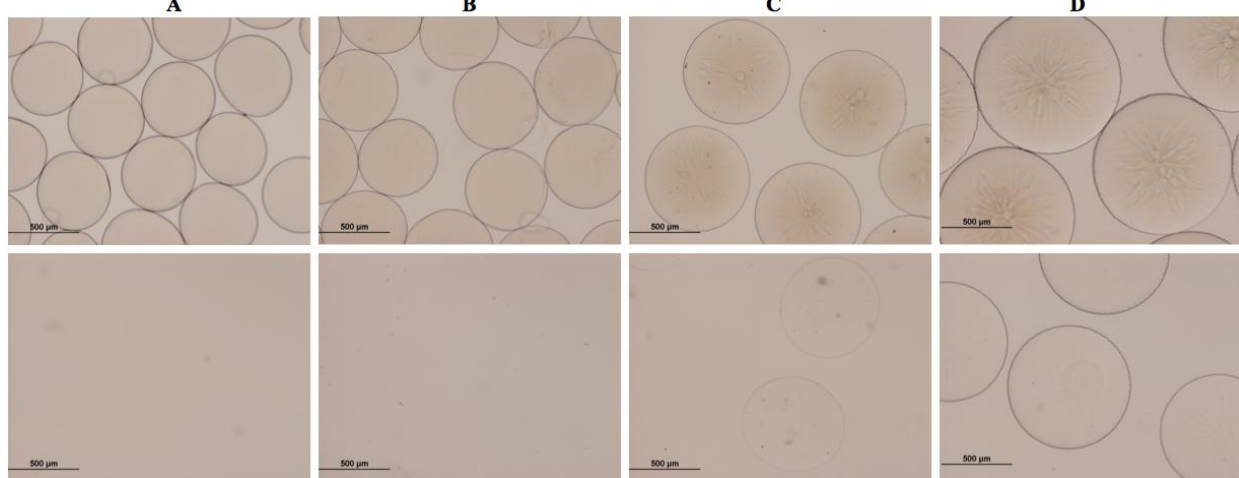
Figure 2. Microsphere preparations with different concentrations of vinyl sulfone-terminated multi-arm poly(ethylene glycol) (PEG-VS) in 1.5% ( w / v ) sodium alginate (Na-alg) PEG-VS concentrations: ( A ) 0% ( w / v ); ( B ) 1.25% ( w / v ); ( C ) 5% ( w / v ) and ( D ) 10% ( w / v ). Upper row before liquefaction; lower row same batches after